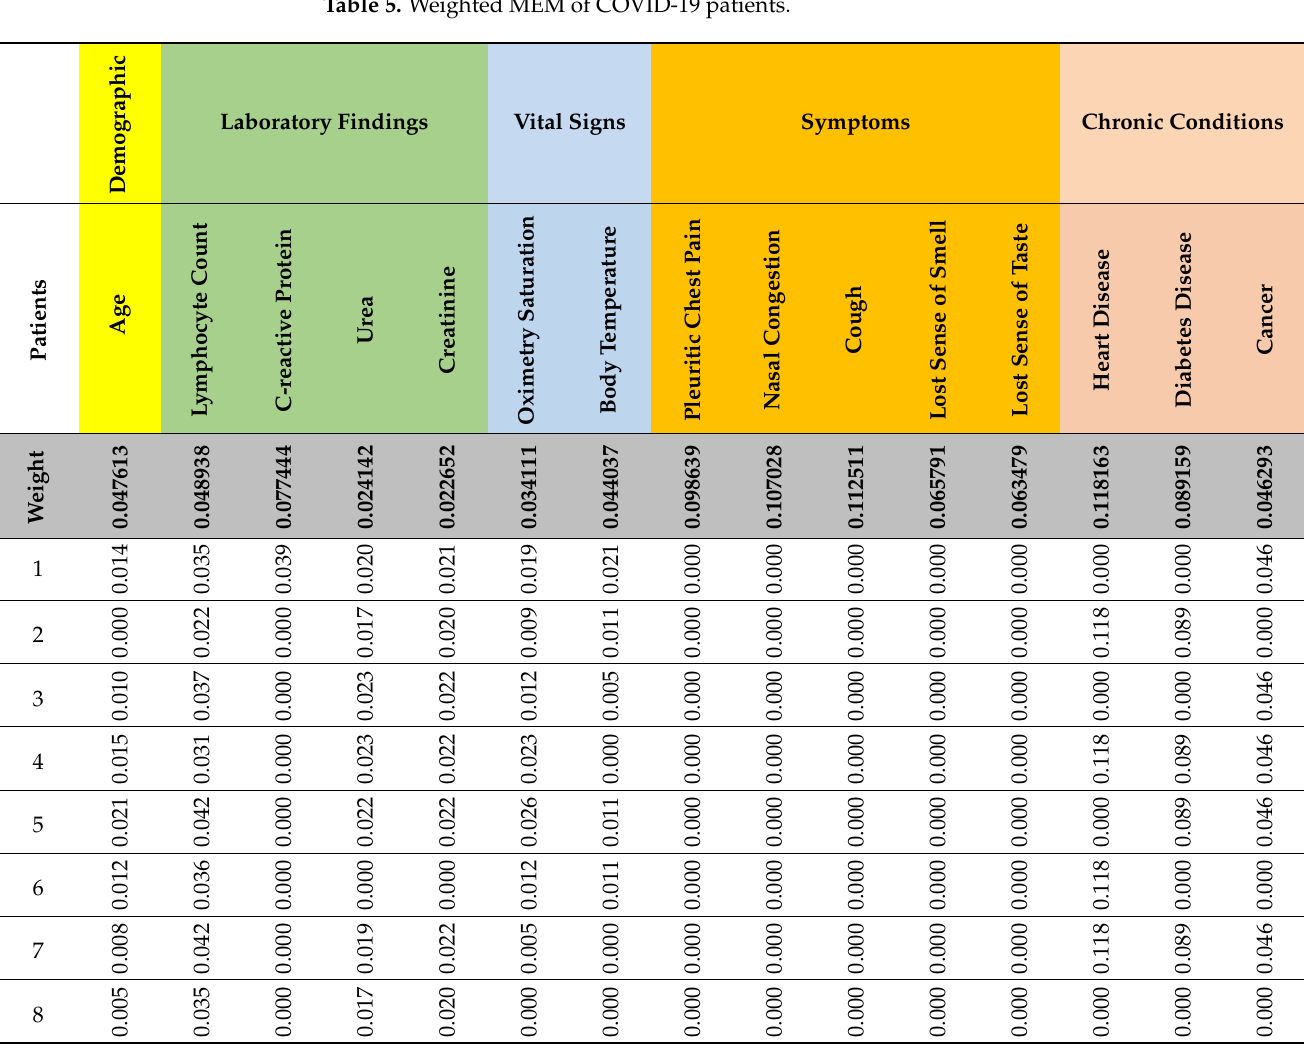
Figure 3. COVID-19 criteria weights. Table 5. Weighted MEM of COVID-19